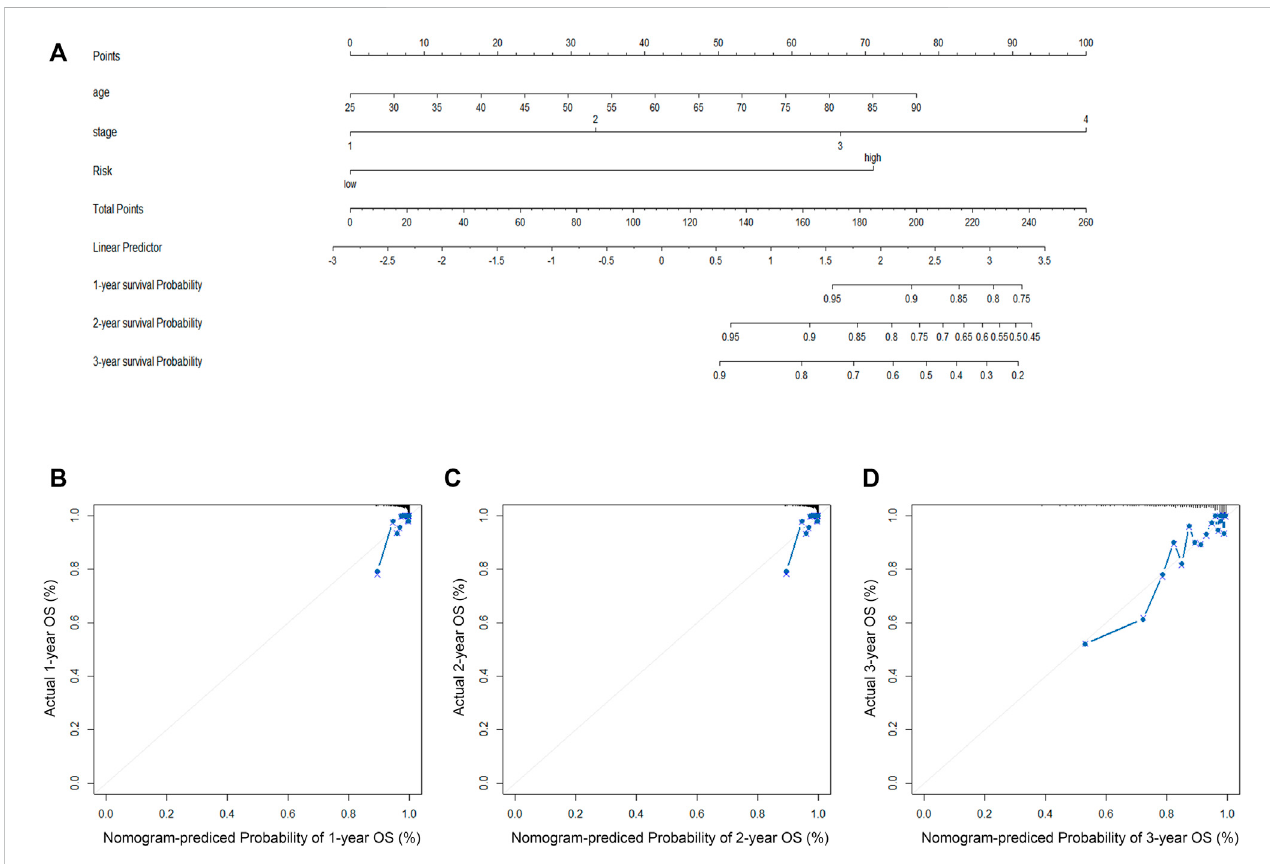
FIGURE 5 (A) The construction of OS predictive nomogram for TCGA-BRCA patients. (B – D) 1-year, 2-year, and 3-year calibration curves of the nomogram combined model in TCGA-BRCA